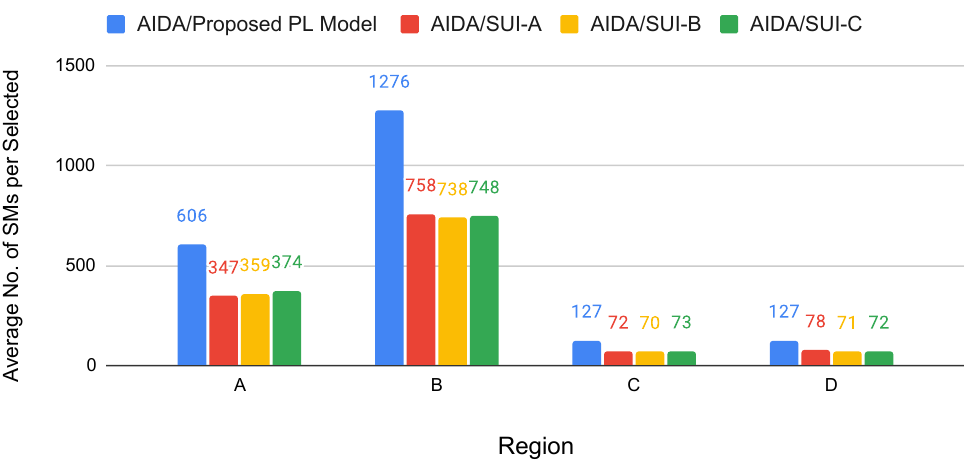
Figure 11. Average number of smart meters (SMs) connected to each CP selected by the AIDA method using its original path loss model (AIDA/proposed PL model) compared to the values connected to the CPs by the AIDA method using Erceg-SUI path loss model for the terrain Category A (AIDA/SUI–A), Category B (AIDA/SUI–B) and Category C (AIDA/SUI–C). The chart compares the performance of AIDA for the Regions A, B, C, and D, used in the